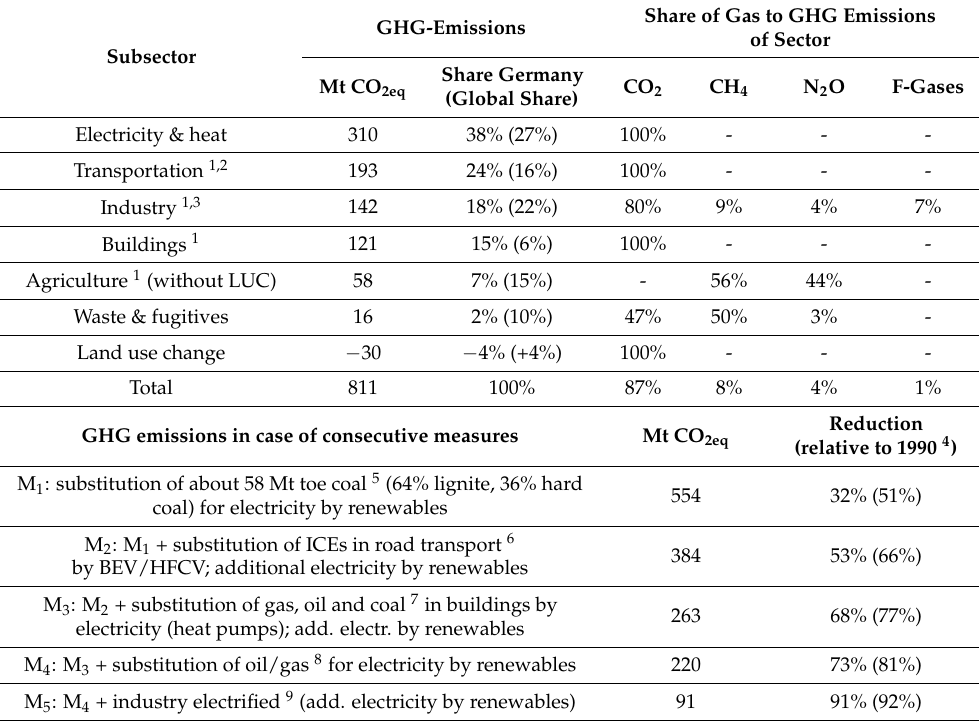
Table 8. GHG emissions of Germany 2018 and if five consecutive measures are taken (data from [2,29] and for fossil fuel consumption in subsectors from [8]. Share of Gas to GHG Emissions GHG-Emissions of Sector Subsector Share Germany Mt CO 2eq CO 2 CH 4 N 2 O F-Gases (Global Share) 310 38% (27%) - -